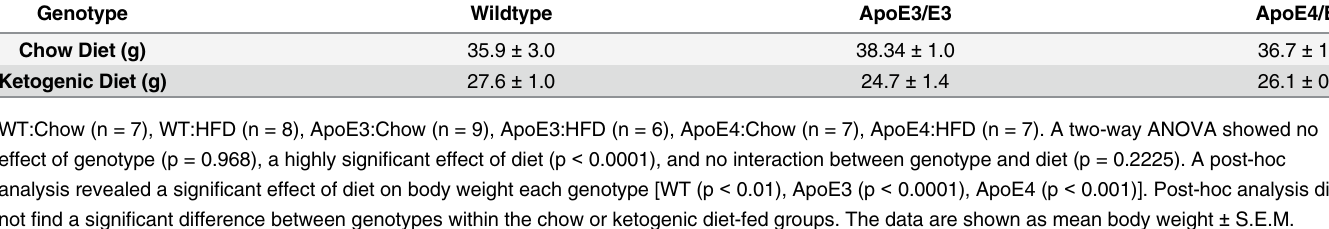
Table 2. Ketogenic diet induces weight loss in wildtype, ApoE3, and ApoE4 mice.